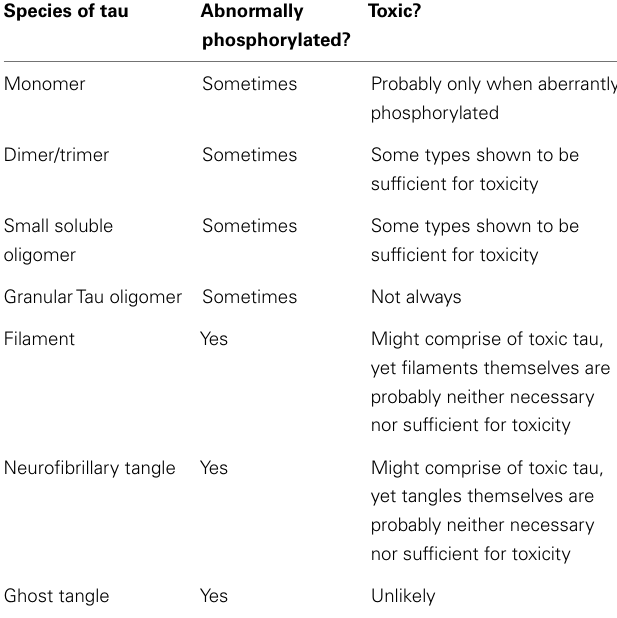
Table 1 | Summary of the major forms of tau